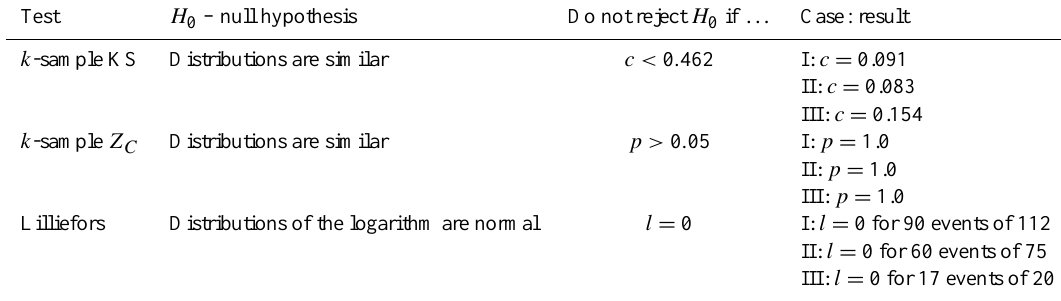
Table 3. Results of the k -sample Kolmogorov–Smirnov (KS), k -sample Z c , and Lilliefors tests for (ψ i,j /g i ) 1 / ˆ σ i . Test H 0 – null hypothesis Do not reject H 0 if